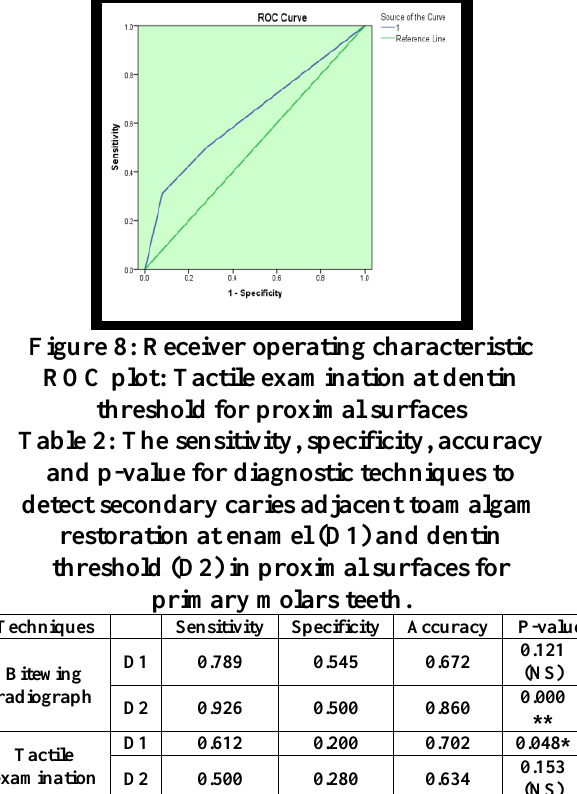
Figure 6: Receiver operating characteristic ROC plot: Bitewing radiograph at dentin threshold for proximal surfaces